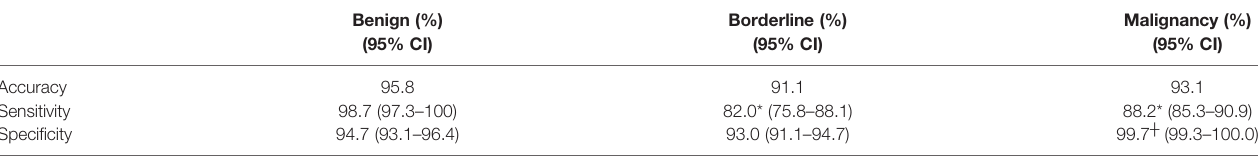
TABLE 4 | The diagnostic performance of intraoperative frozen